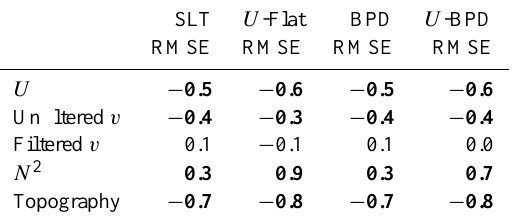
Table 3. Correlation coefficient between the root mean square er- rors of the theoretical sections compared to the model section for different variables. Correlations significant at 0.01 are in bold.